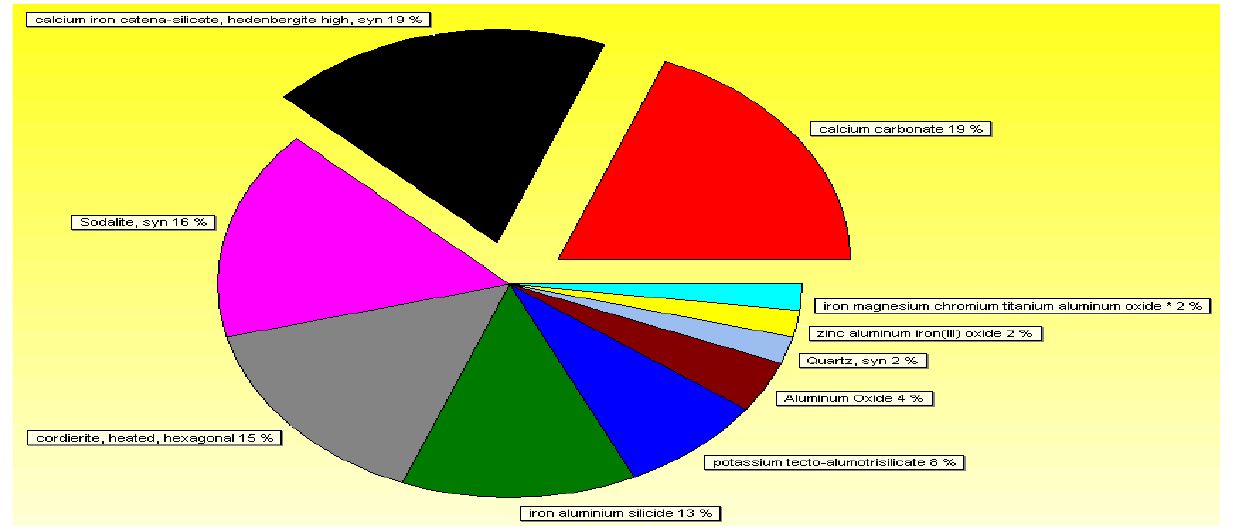
Figure 5. X-ray diffraction pattern of the spent sorbent after wastewater treatment.